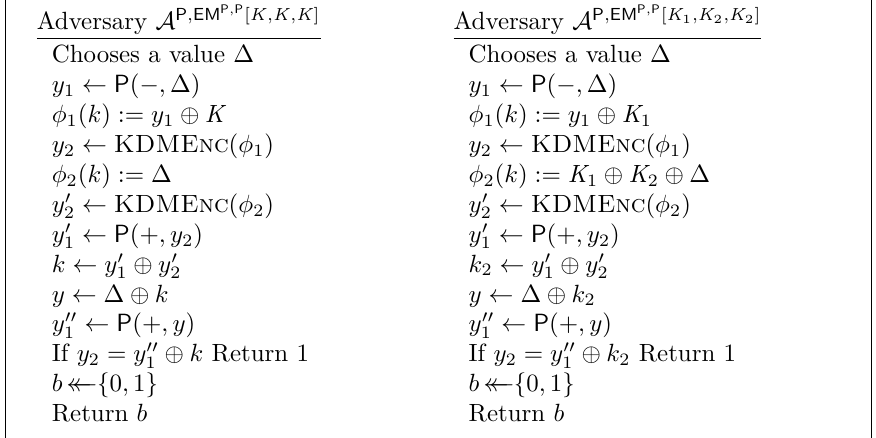
Figure 8: Adversaries A P , EM P , P [ K , K , K ] and A P , EM P , P [ K 1 , K 2 , K 2 ]